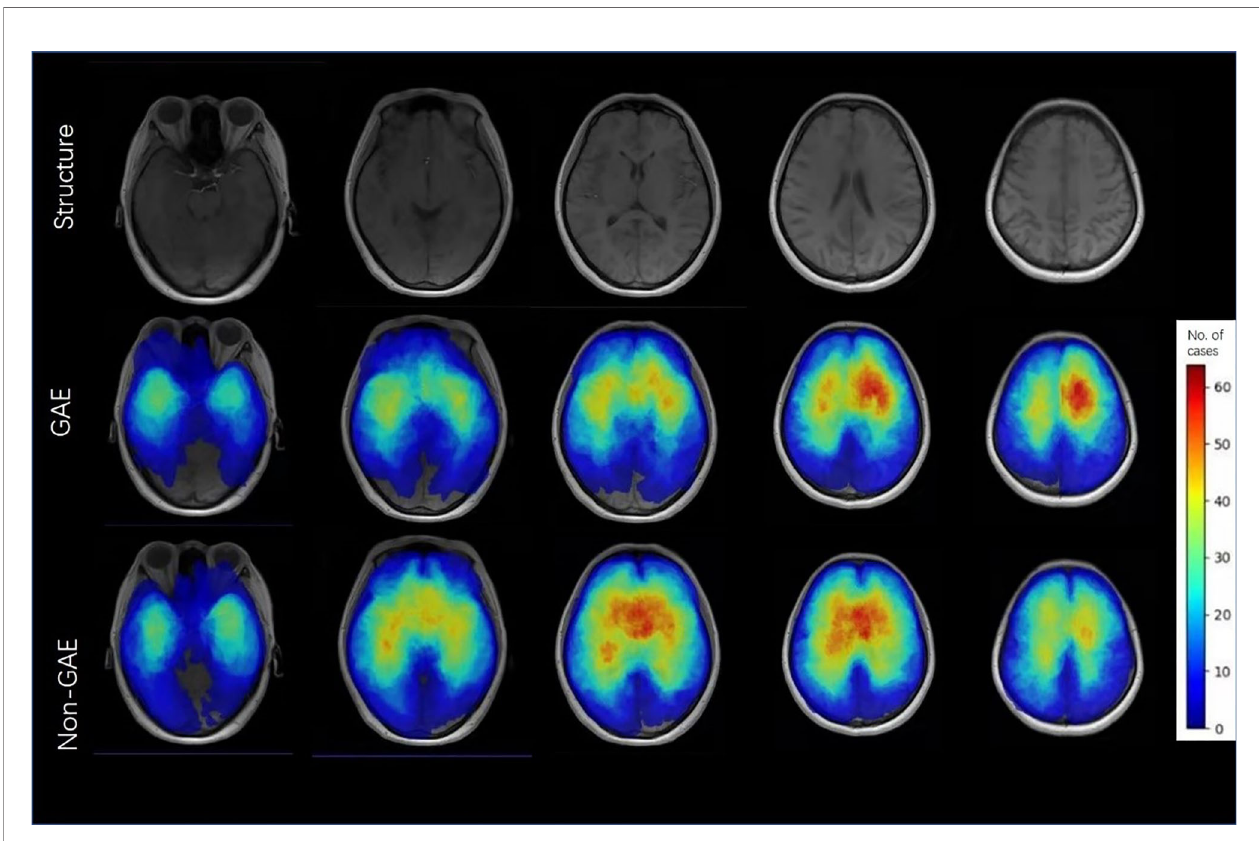
FIGURE 2 | Color frequency map illustrates the location of and number of patients with glioma-associated epilepsy and non-GAE. Images are displayed in neurologic display convention.